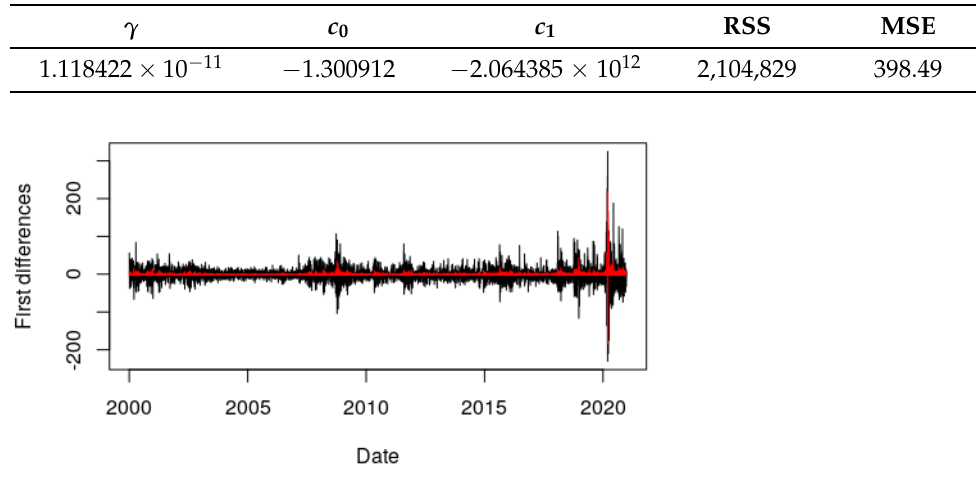
Table 6. Result of implementation of nlstac for pattern (16), RSS being the residual sum of squares and MSE = RSS / n where n = 5282 is the number of observations.